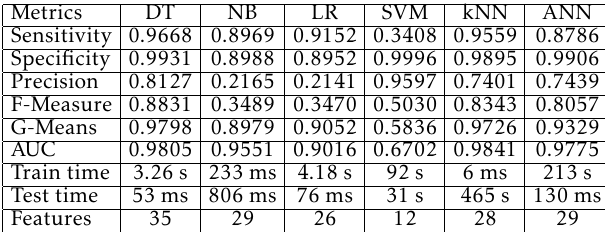
Table 12. Results of using GR-BFE algorithm on BACKDOOR. Metrics